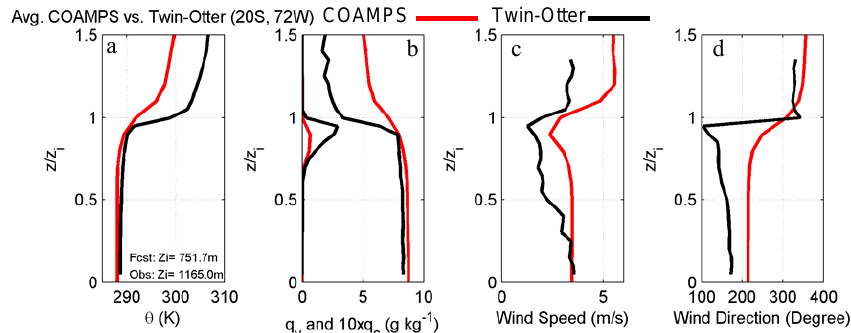
Fig. 8. Comparison between COAMPS and Twin Otter averaged soundings scaled by the boundary layer heights. (a) θ ; (b) q v and 10 × q c ; (c) wind speed; and (d) wind direction.